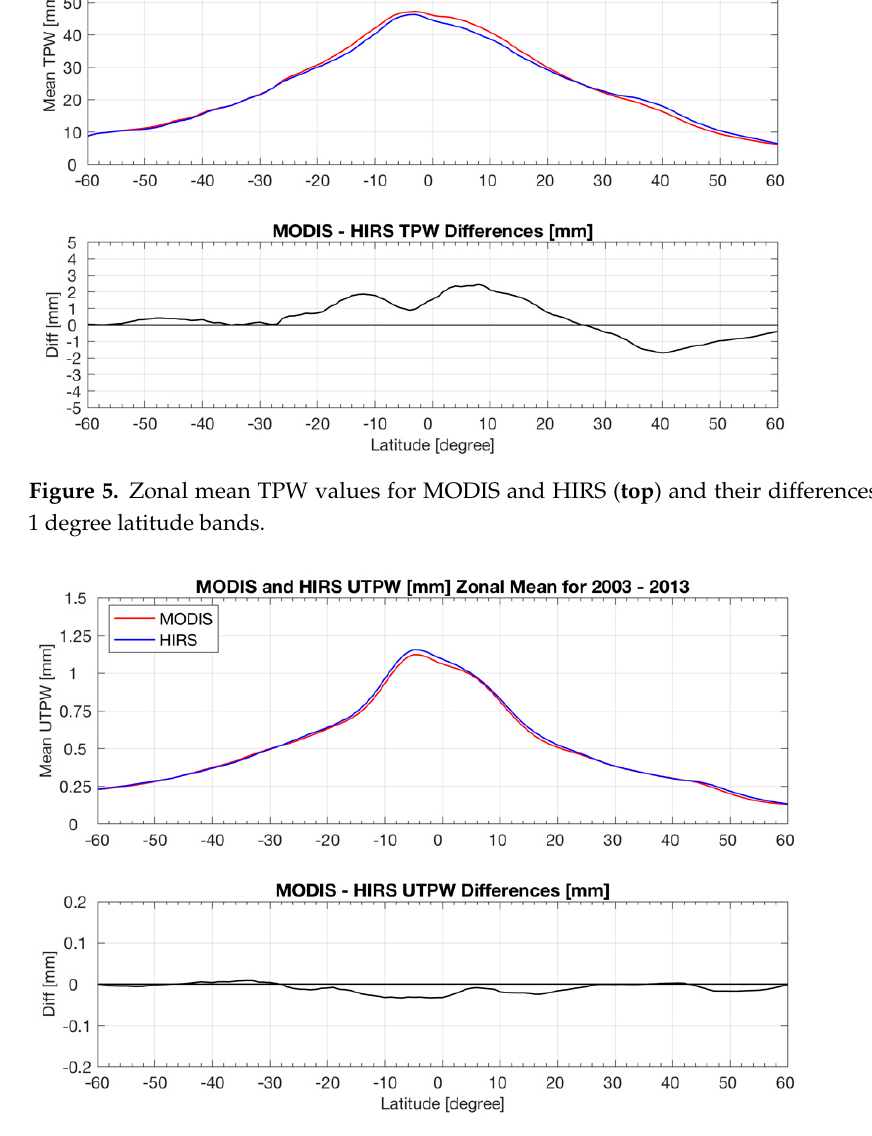
Figure 6. Zonal mean UTPW values for MODIS and HIRS ( top ) and their differences ( bottom ) for 1 degree latitude bands.